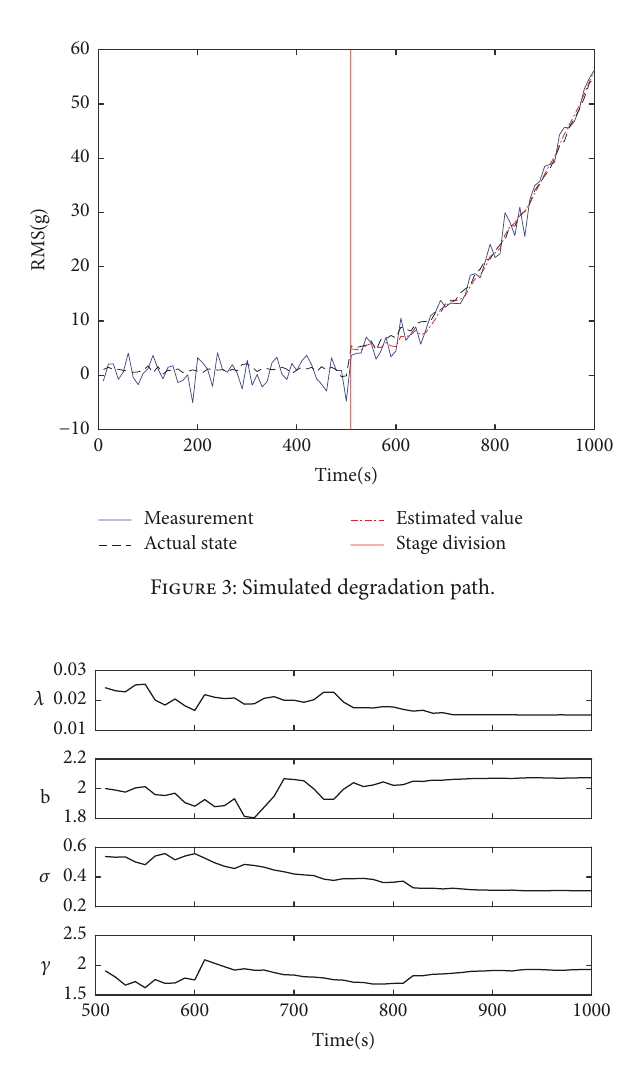
Figure 4: Evolution of the parameters.